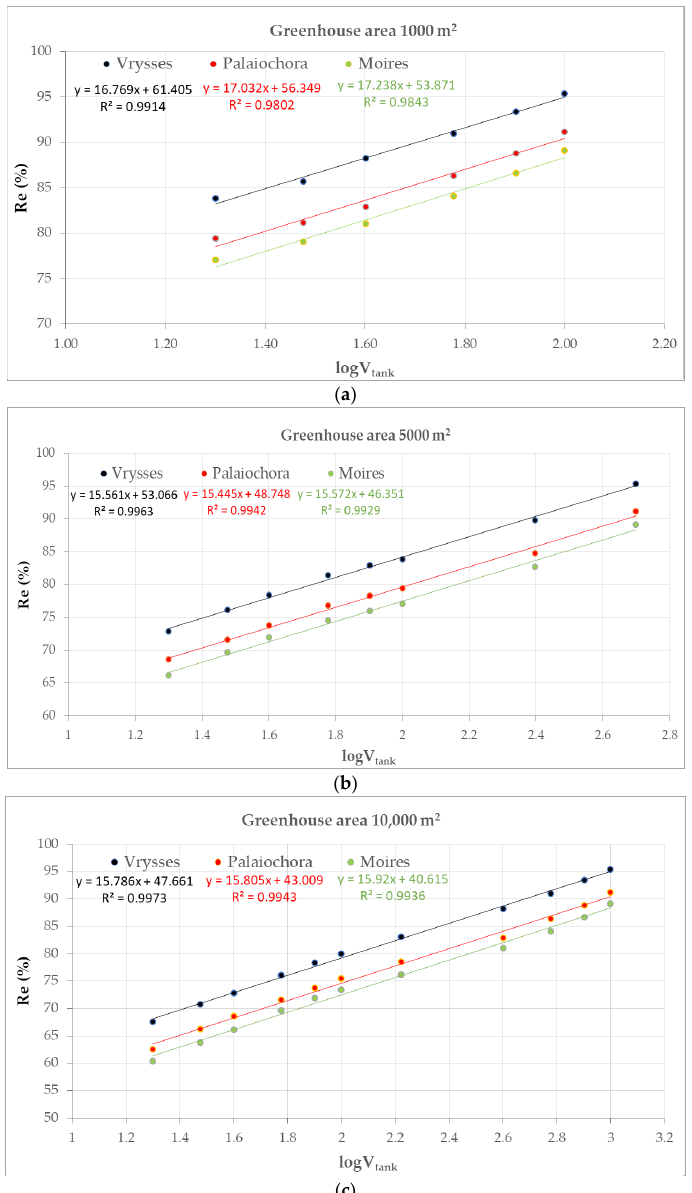
Figure 7. Comparative presentation of the relationships between reliability coefficients and log values of covered rainwater tank volumes, Re (log V tank ), for meeting the tomato crop water needs for ( a ) 1000 m 2 , ( b ) 5000 m 2 and ( c ) 10,000 m 2 greenhouses in three study areas (Vrysses, Palaiochora and Moires). The volumes of V tank are in m 3